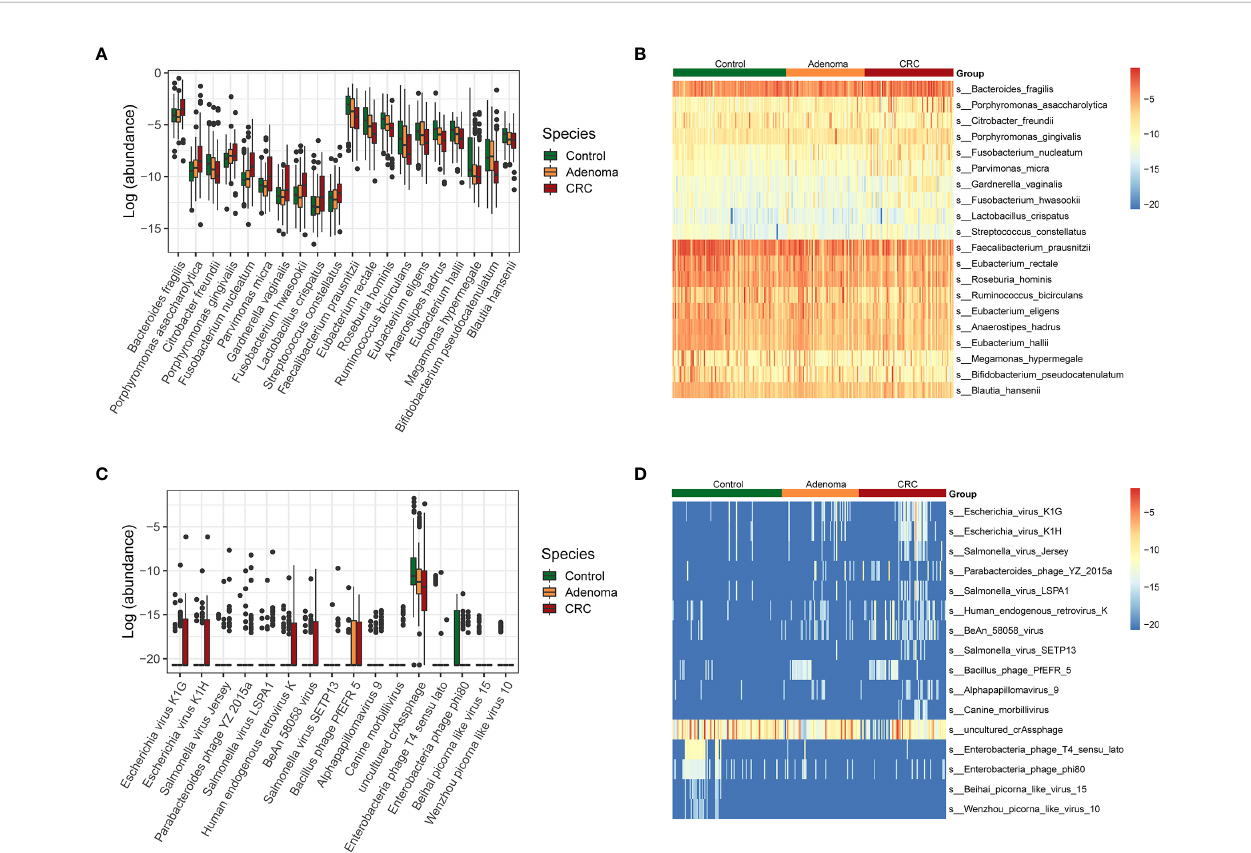
FIGURE 2 | Relative abundances of bacterial and viral species in control (colored in green), adenoma (colored in amber), and CRC (colored in dubonnet) groups. (A) Top 10 bacteria showed increased or decreased relative abundance in the CRC group than in the control group. The vertical axis represents relative abundance. (B) Heatmap of the top 10 bacteria that showed increased (top 10) or decreased (lower 10) relative abundance in the CRC group compared with that in the control group. (C) The 15 viruses that were different in relative abundance between the control and CRC groups, including 11 enriched and top 4 depleted in the CRC group. (D) Heatmap of the 15 viruses that were different in relative abundance between the control and CRC